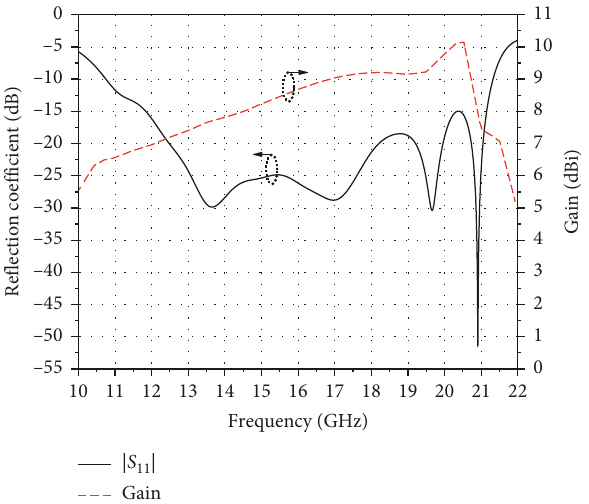
Figure 5: The simulated S-parameters and gain of the antenna